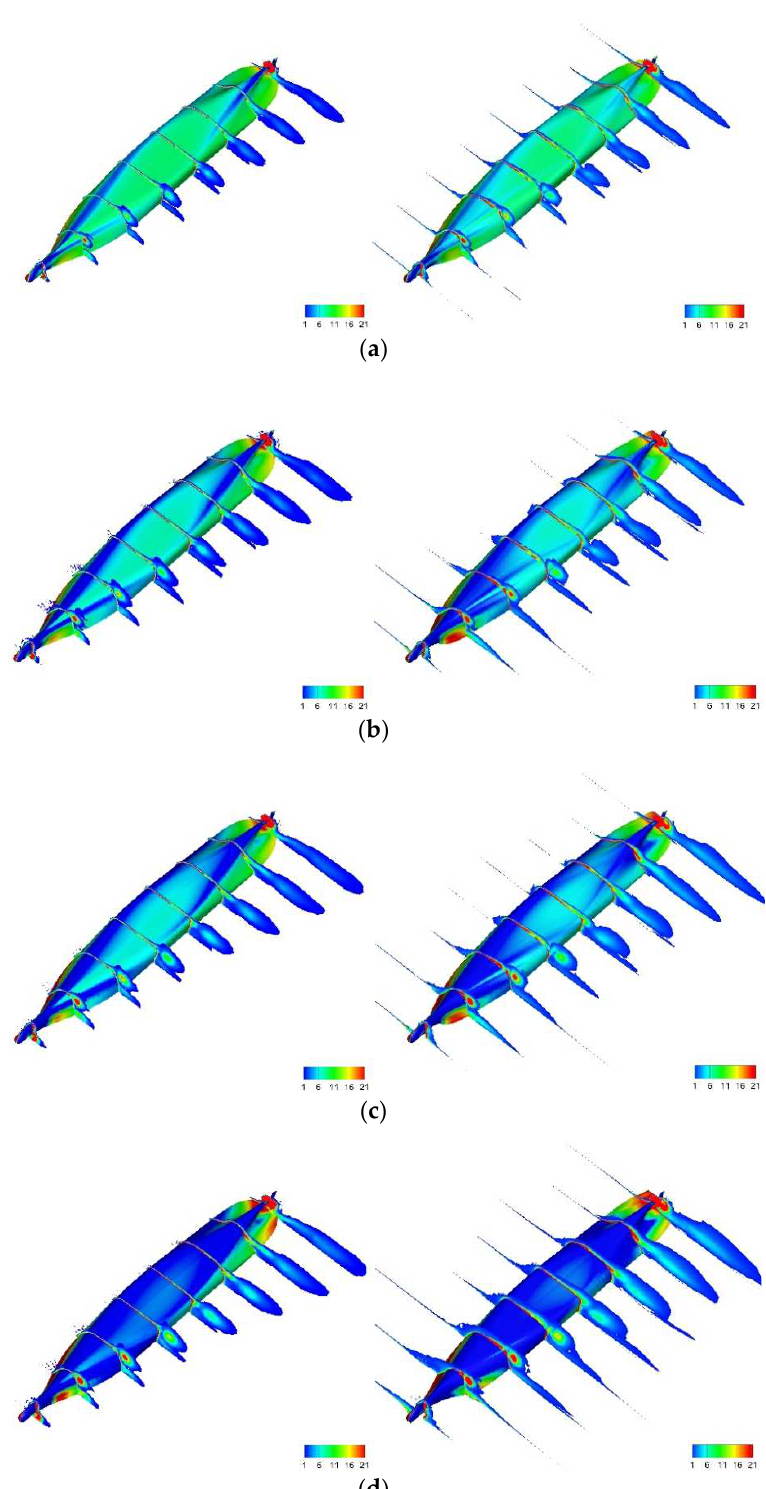
Figure 6. Cross sections of flow field for simulations of double-body flow ( left ) and water–air flow ( right ). ( a ) Fr = 0.156, β = 16 deg. ( b ) Fr = 0.201, β = 16 deg. ( c ) Fr = 0.201, β = 20 deg. ( d ) Fr = 0.260, β = 20